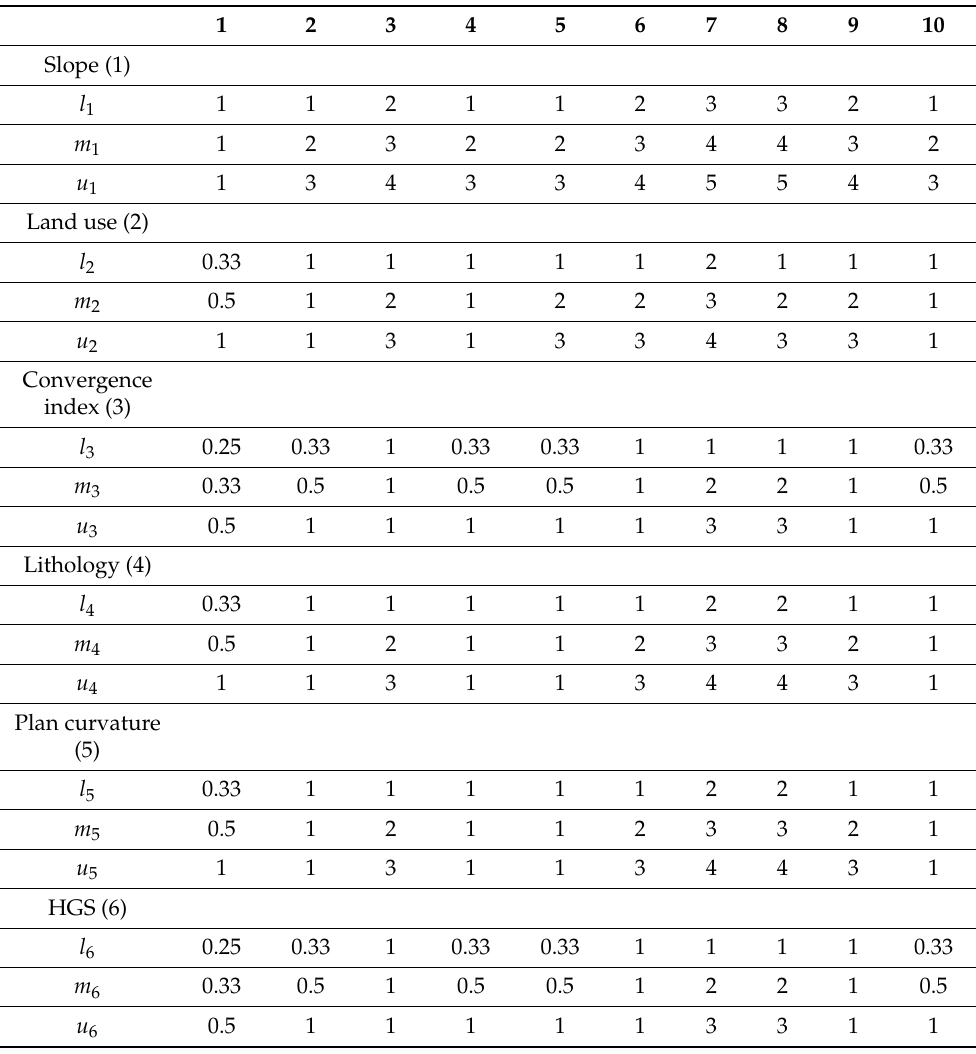
Table 2. Fuzzy analytical hierarchy process evaluation